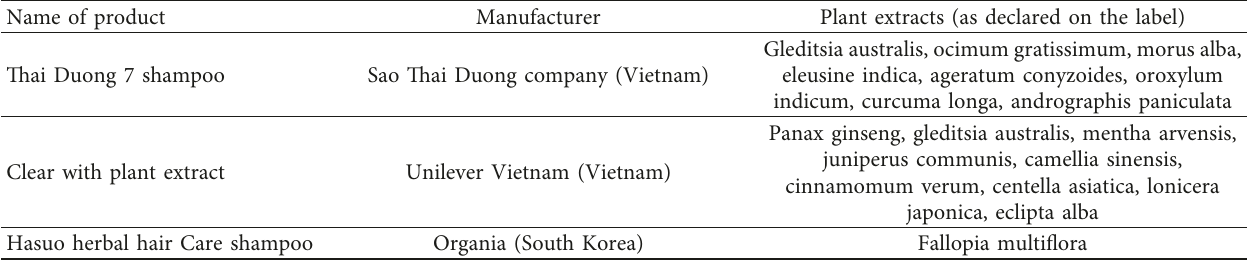
Table 1: Information about shampoos containing plant extracts used for method development and validation. Name of